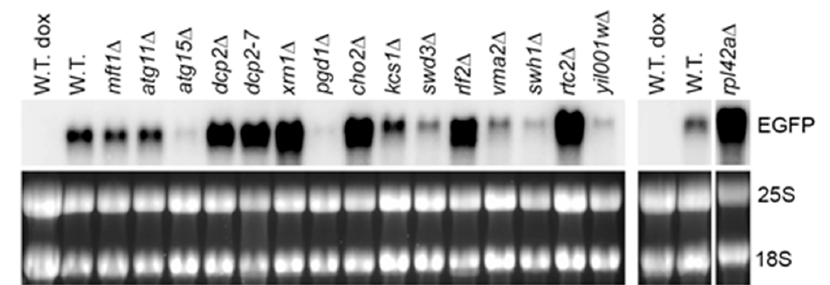
Figure 2. The model RNA accumulates in mutants with constitutive stress granules. Northern blot analysis was performed on total RNA from wild-type strain (W.T., BY4741) and mutants (indicated above each line) transformed with episomal plasmid expressing the model RNA in Tet-Off system. The model RNA was detected with the probe to EGFP . Ribosomal RNA (25S and 18S) was visualized by ethidium bromide staining and served as endogenous control. RNA from uninduced cells (dox) served as control for unspecific hybridization. The wide white vertical line indicates that the samples were run on two different gels. The narrow white vertical line indicates that the samples were run on the same gel, but some lines between left and right part were removed. Full-length gel and blot for the cropped images are shown in Supplementary File 1: Figure S3A.